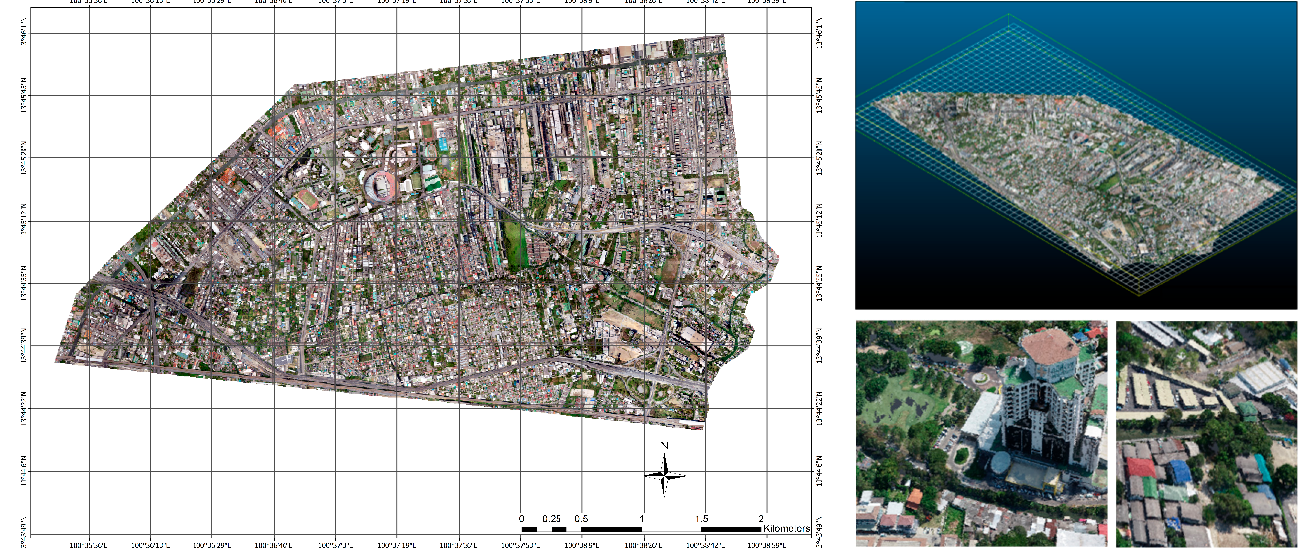
Figure 2. Digital Elevation Model (DEM) of the Ramkhamhaeng polder, Bangkok, Thailand [80].